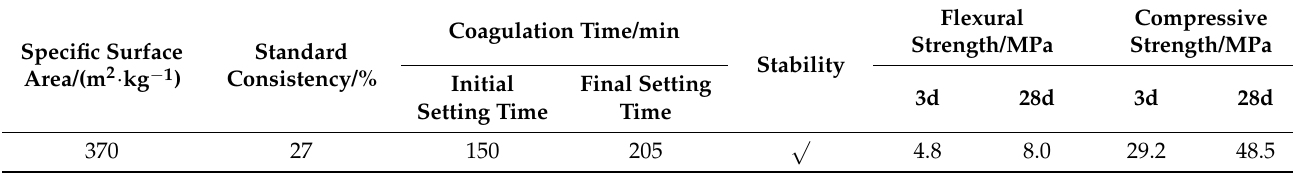
Table 1. Physical and mechanical properties of cement.